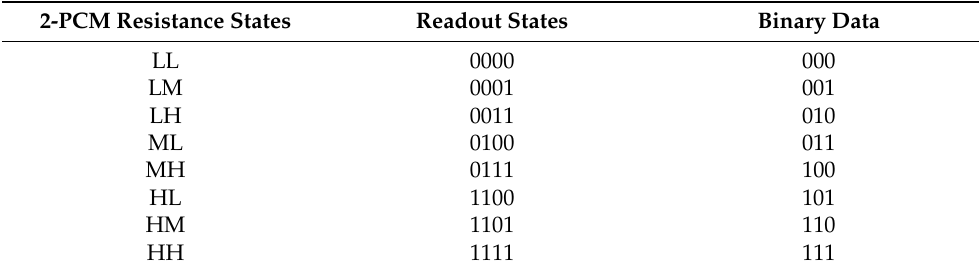
Table 2. The mapping relationship between readout states and data